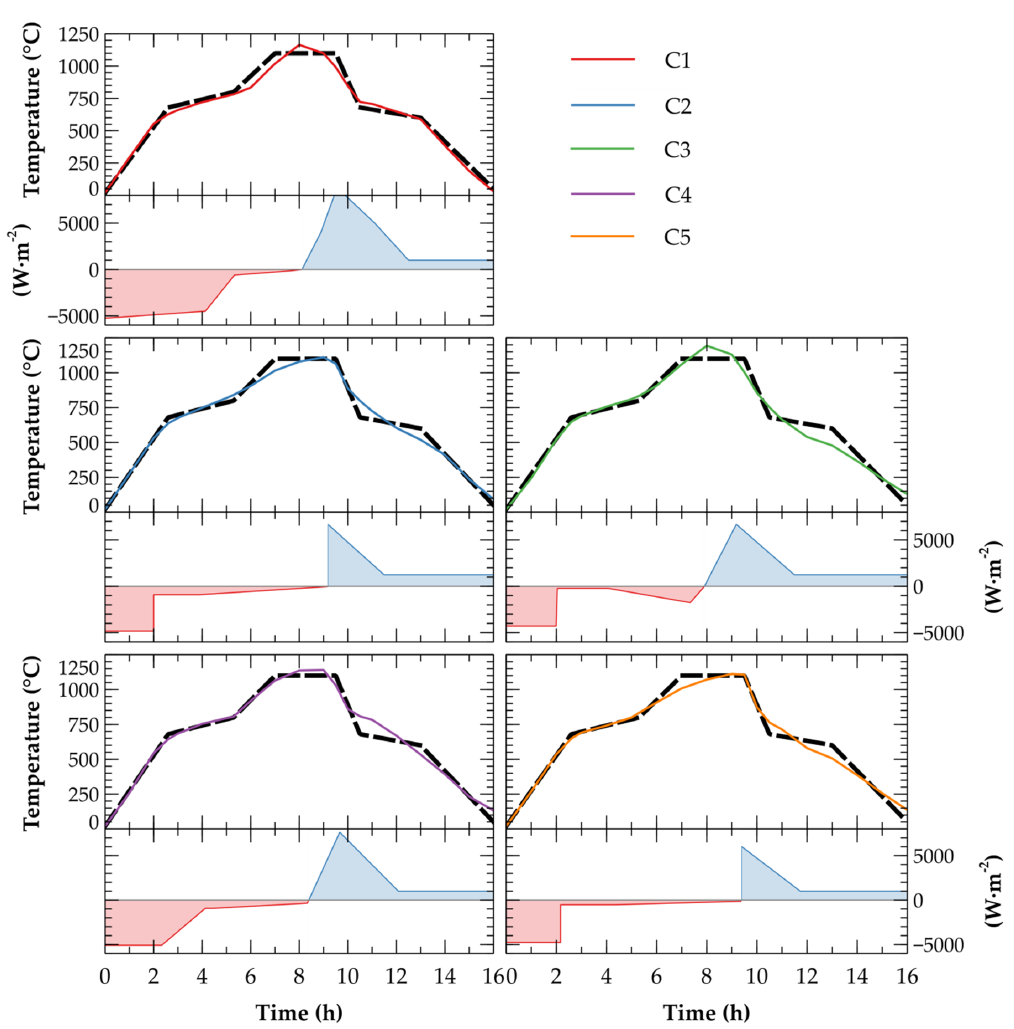
Figure 10. Evolution of temperatures in particular clays when exposed to optimized firing schemes.